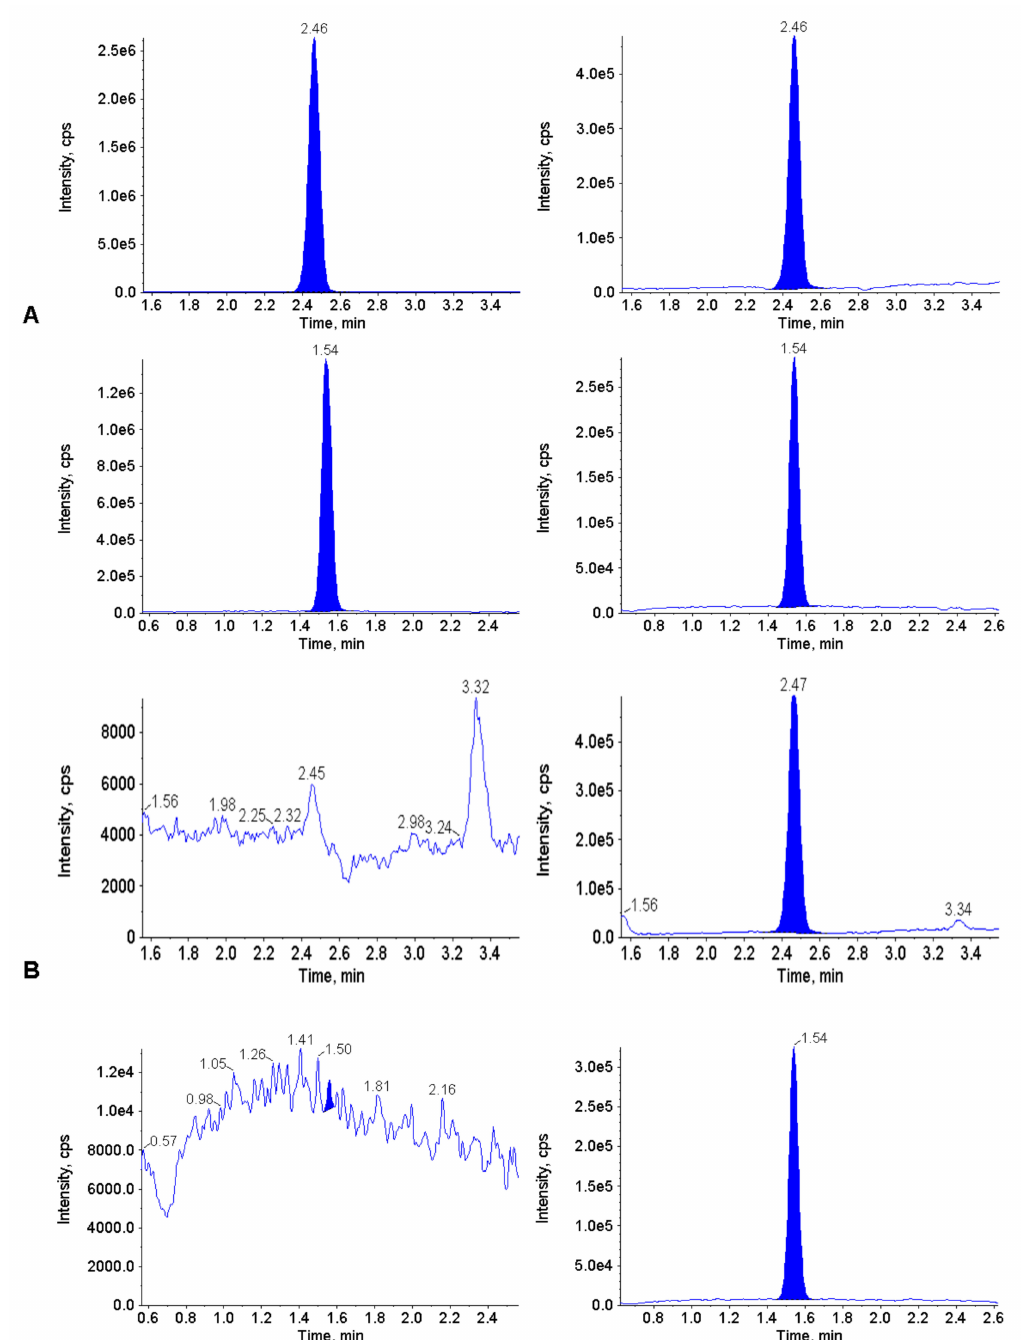
Figure 4. LC-MS / MS chromatograms of extracted plasma from patient 1 pre ( A : upper panel thymidine; lower panel 2’deoxyuridine) and during treatment with EE-TP ( B : upper panel thymidine; lower panel